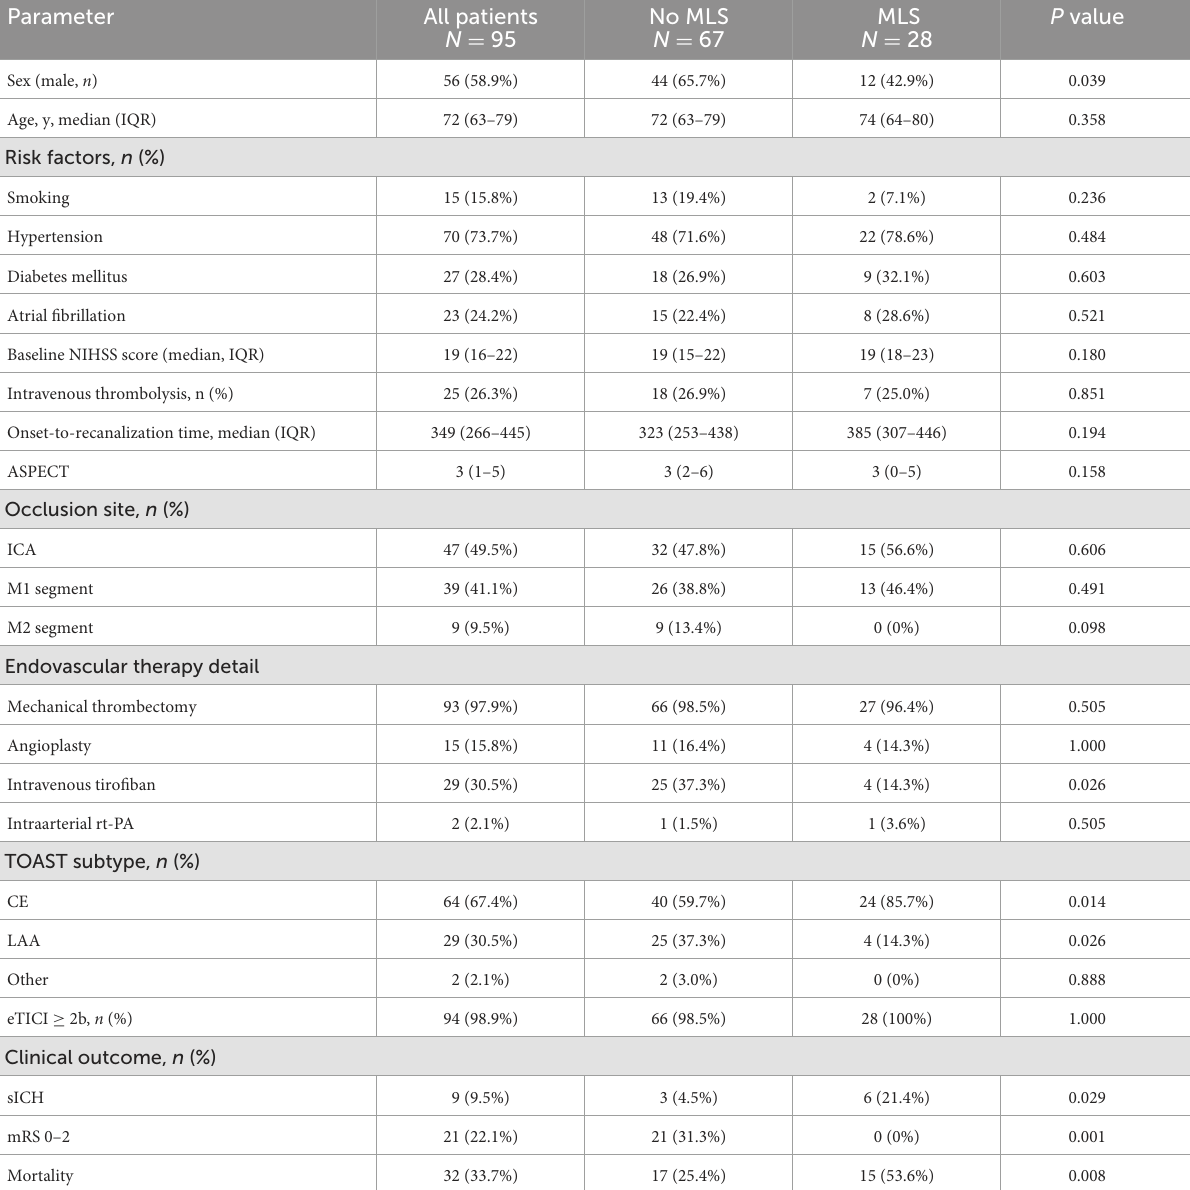
TABLE 1 Comparison of baseline characteristics between patients with early severe MLS presence and without early severe MLS presence. Parameter All patients N =